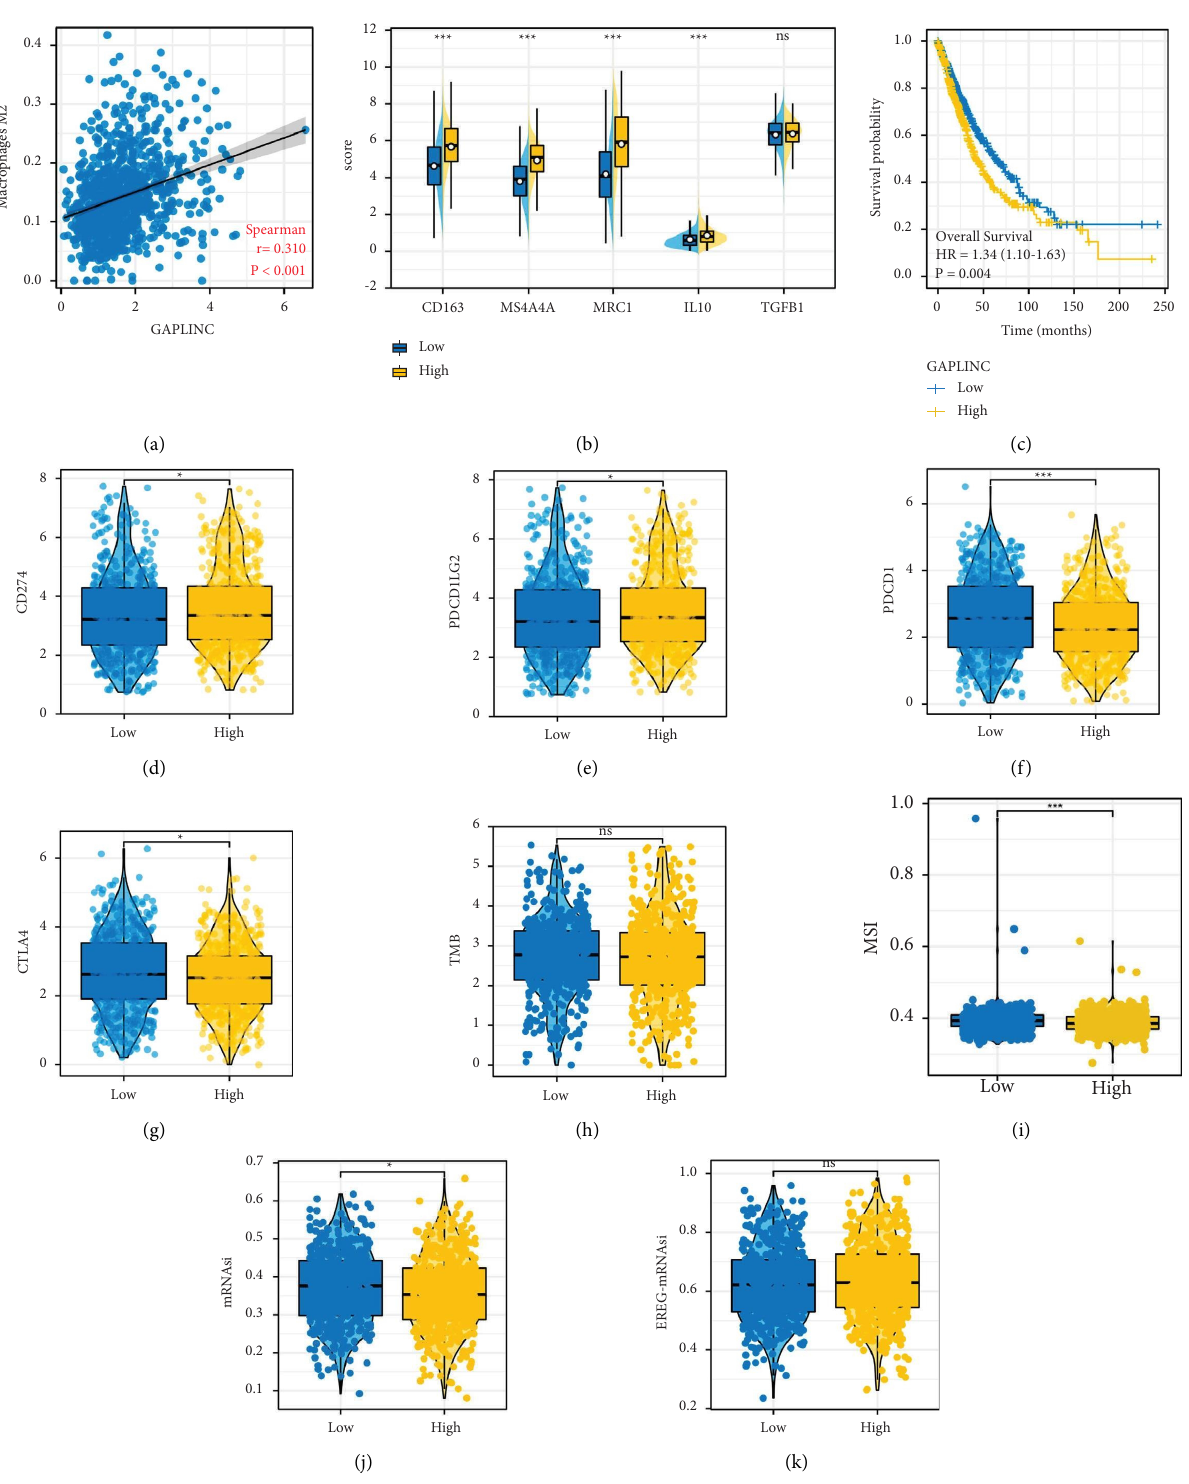
Figure 7: GAPLINC induces M2 macrophages polarization. (a) Correlation between GAPLINC and M2 macrophages based on public data; (b) M2 macrophage-related molecules were highly expressed in the patients with high GAPLINC expression; (c) KM survival curve of patients with high and low GAPLINC expression; (d)–(g) hub immune checkpoints level in patients with high and low GAPLINC ex- pression; (h)–(k) TMB, MSI, mRNAsi, and EREG-mRNAsi diference in patients with high GAPLINC